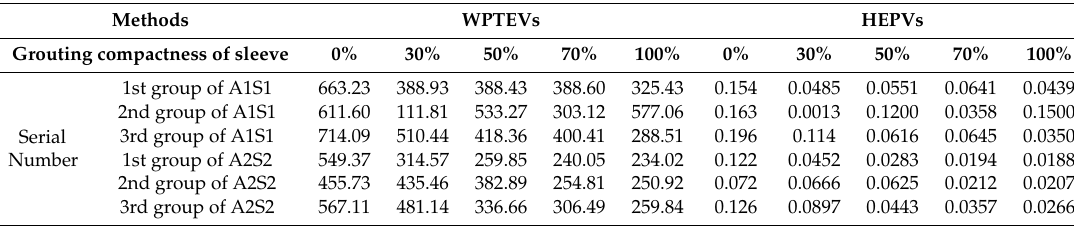
Table 3. Grouting-compactness indices.